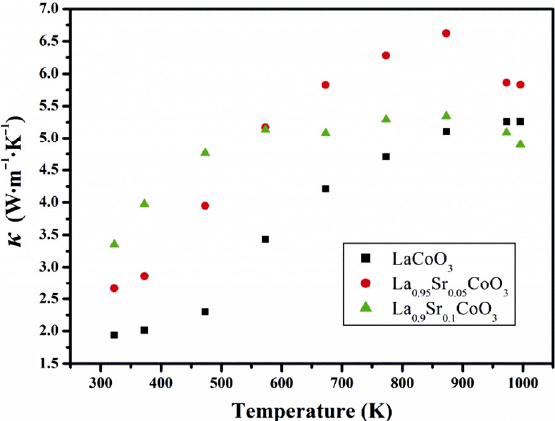
Fig. 11 Temperature dependence of the thermal conductivity of the La 1– x Sr x CoO 3 sample with x = 0, 0.05, and 0.1.